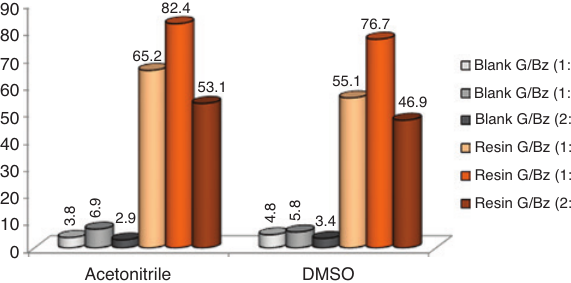
Figure 4: Glycerol conversion (%) comparison ratios versus organic solvents. Errors deviation in